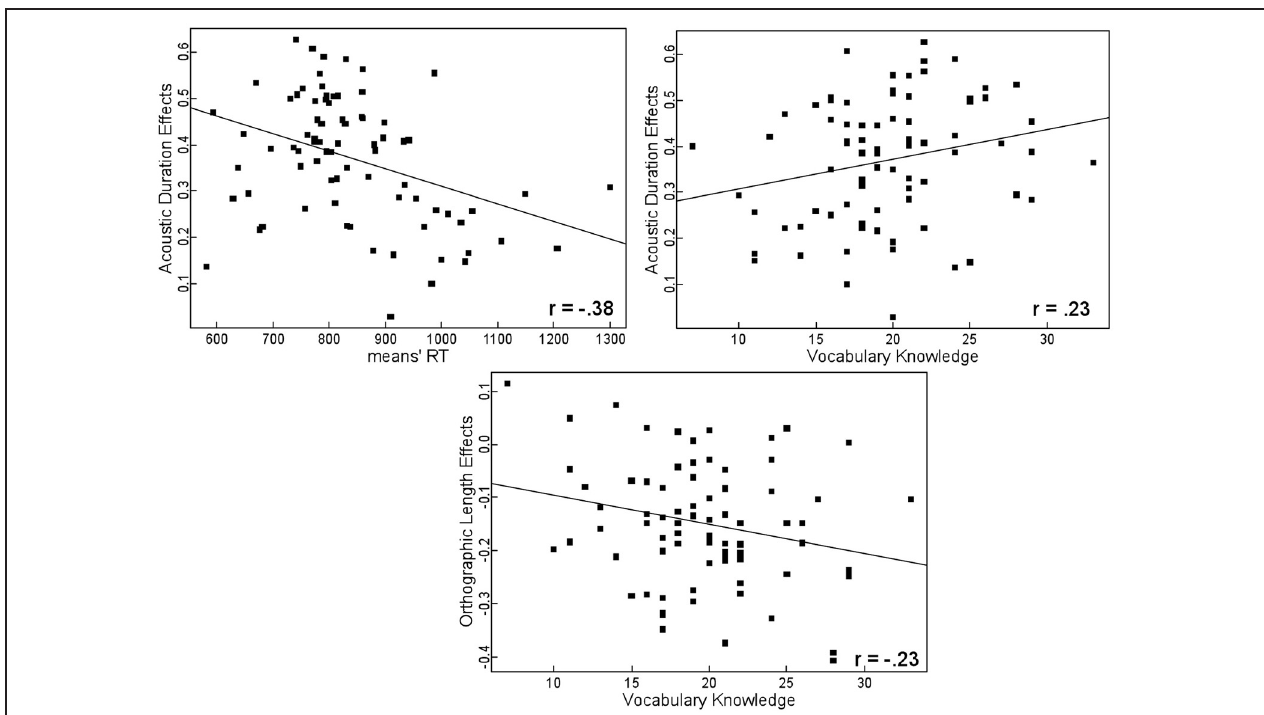
FIGURE 2 | Relations between participants’ performance, vocabulary knowledge and acoustic duration, and orthographic length effects.